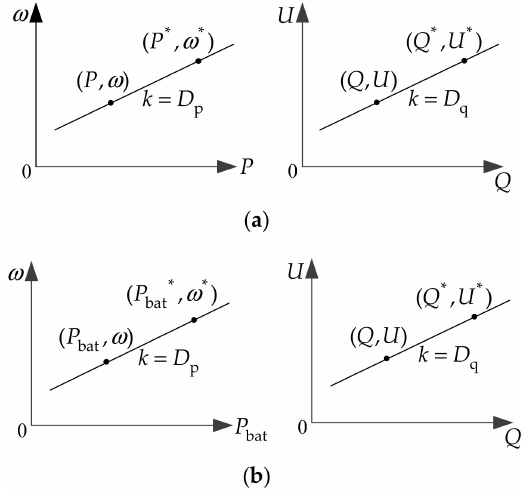
Figure 3. Comparison chart of the droop curves ( a ) Traditional droop curves; ( b ) Droop curves based on charging